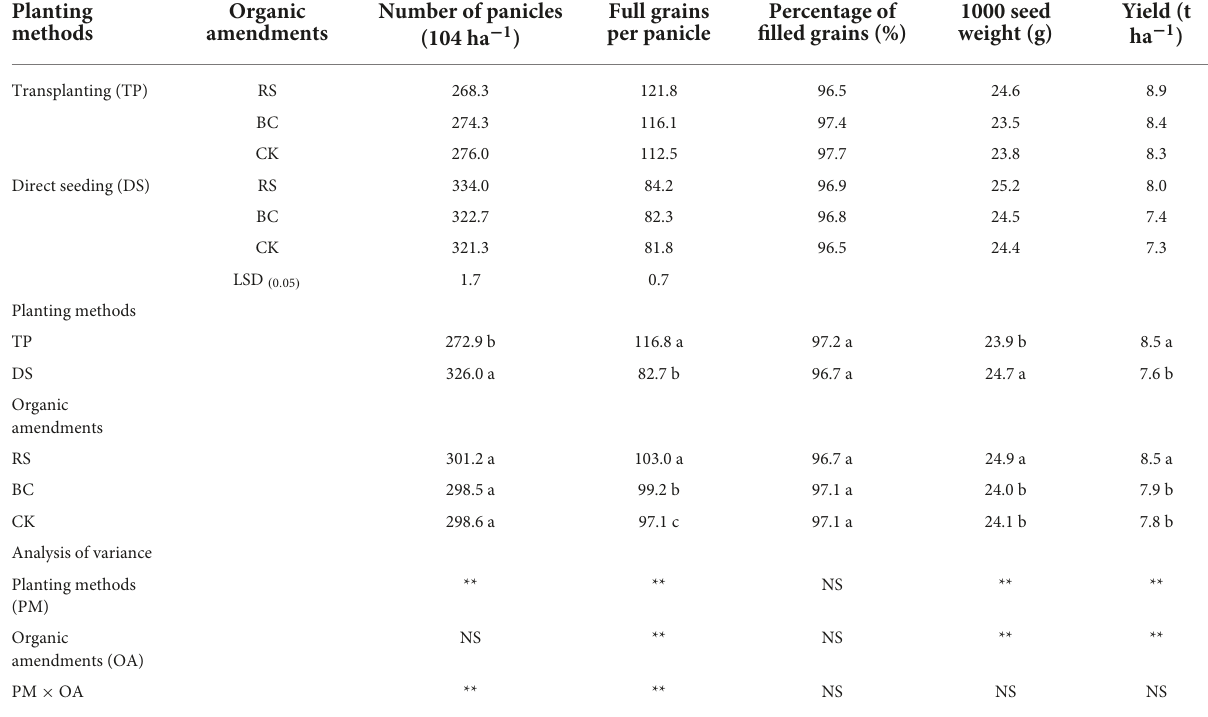
TABLE 1 Effects of planting methods and organic amendments on grain yield and components. Planting methods